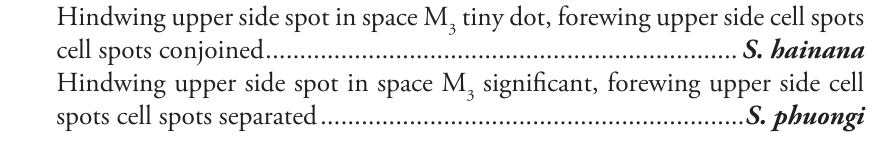
Fig. 3 Scobura masutaroi Sugiyama, 1996: 9 (Type locality: Dujiangyan, Sichuan, China) Scobura mouchai Krajcik, 2013: 2, syn. n. (Type locality: Fengxian, Shaanxi, China) Material examined. 1 ♂ , 1 ♀ , Nibashan, Rongjing, Sichuan, 26.VII.2009, Min Wang; 1 ♂ , Jialingjiang, Fengxian, Shaanxi, 15.VII.2010, Min Wang. Diagnosis. Forewing length 17–18 mm. This species is different from other spe- cies of S. coniata group in the appearance of the wing upper side: forewing with yellow streak in subcosta space basally, a big cell spots solid across cell, the spot in space CuA 2 yellow; hindwing with spots in spaces CuA and M -M yellow. Wing under side: fore- 1 1 2 wing costal and submarginal spots yellow; hindwing all veins and submarginal spots from spaces Sc+R to CuA yellow; and all yellow submarginal spots conjoined both 1 2 forewing and hindwing.